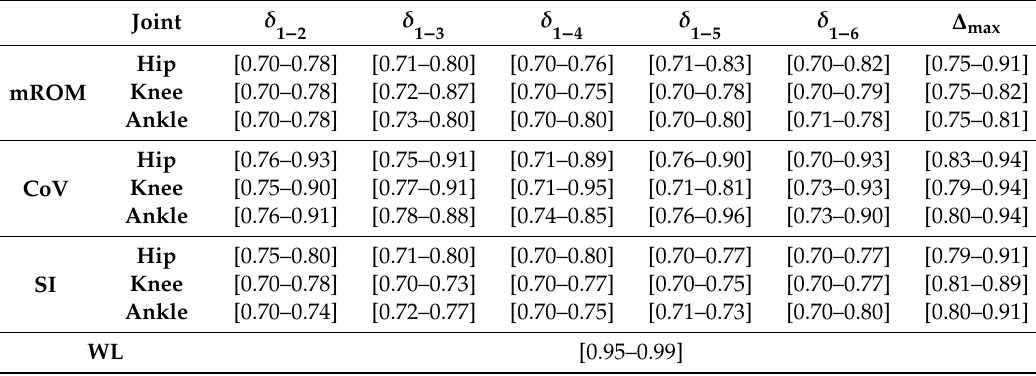
Table 2. Range of the inter-class correlation coe ffi cient (ICC) values related to the intra-day reliability analysis for synthetic indices related to the 6-min walking test (6MWT). We considered together the results for the left and right side due to the low value of symmetry index (SI)